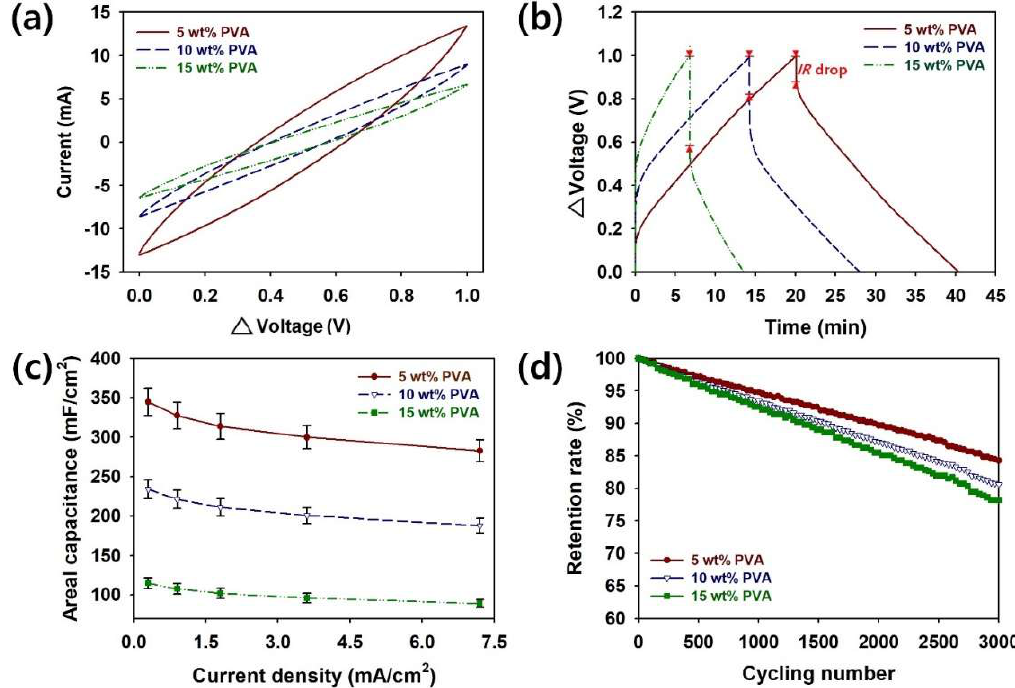
Figure 4. ( a ) CV curves, ( b ) GCD curves, ( c ) rate capability curves, and ( d ) retention rate curves of PVA–PANI HDGs with di ff erent PVA contents.